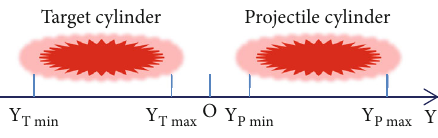
y y y P min , P max , T min , and T max